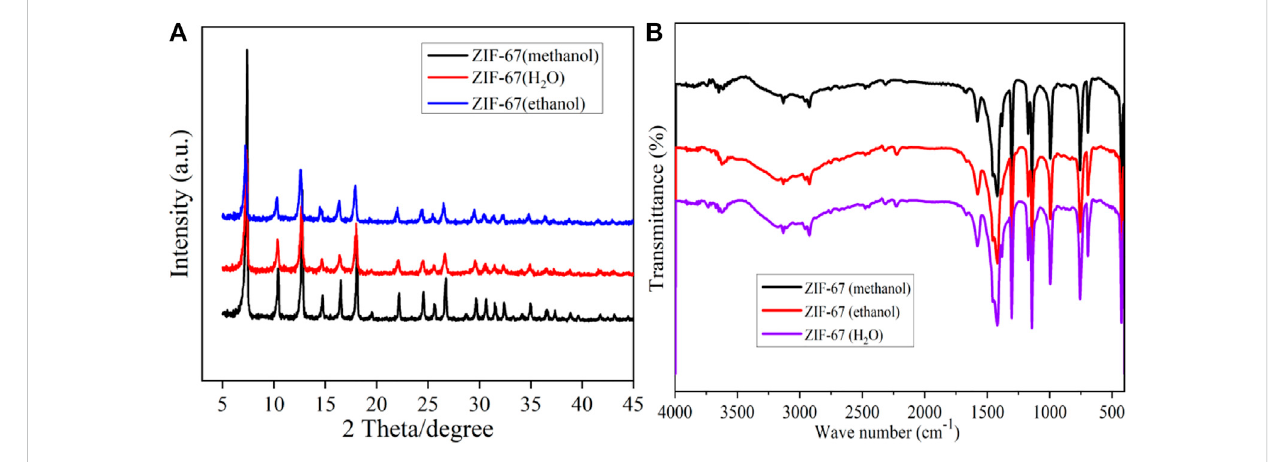
FIGURE 1 The XRD (A) and FT-IR (B) of ZIF-67.